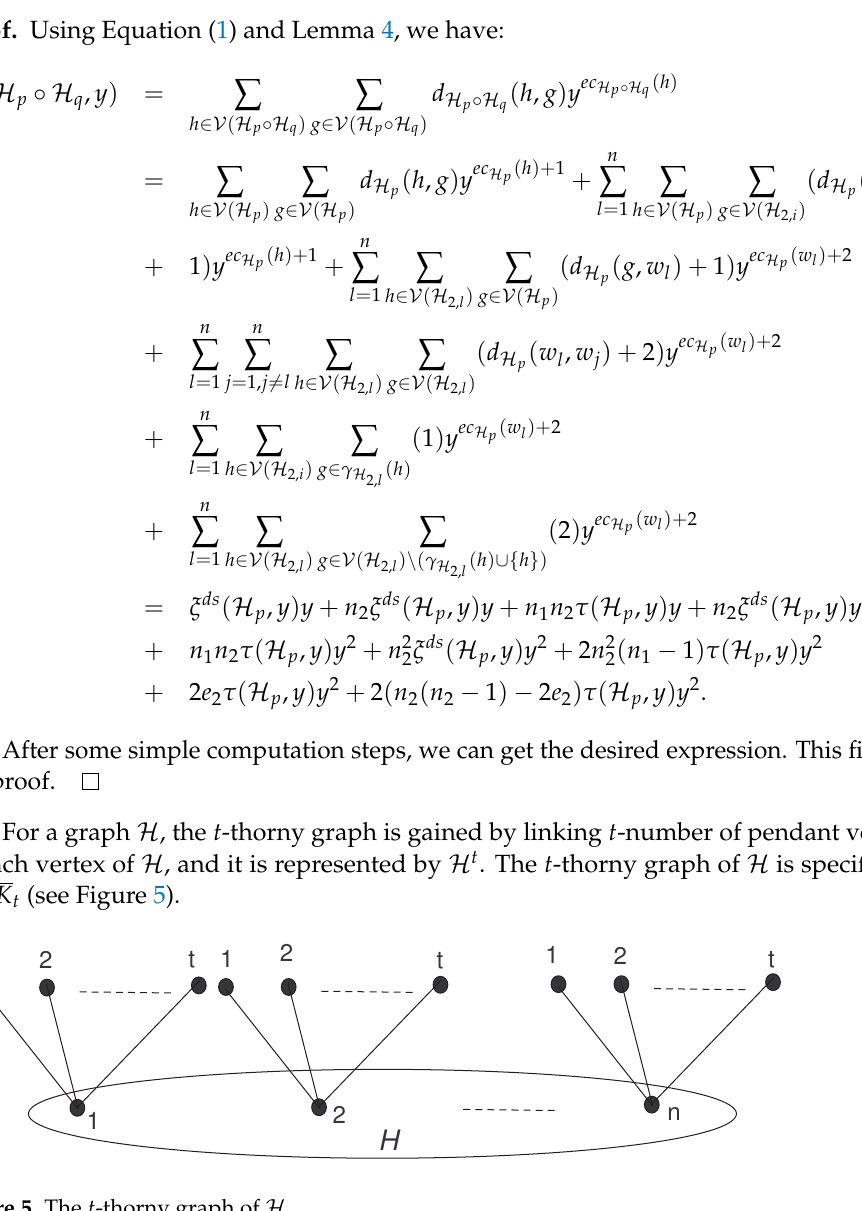
Figure 5. The t -thorny graph of H